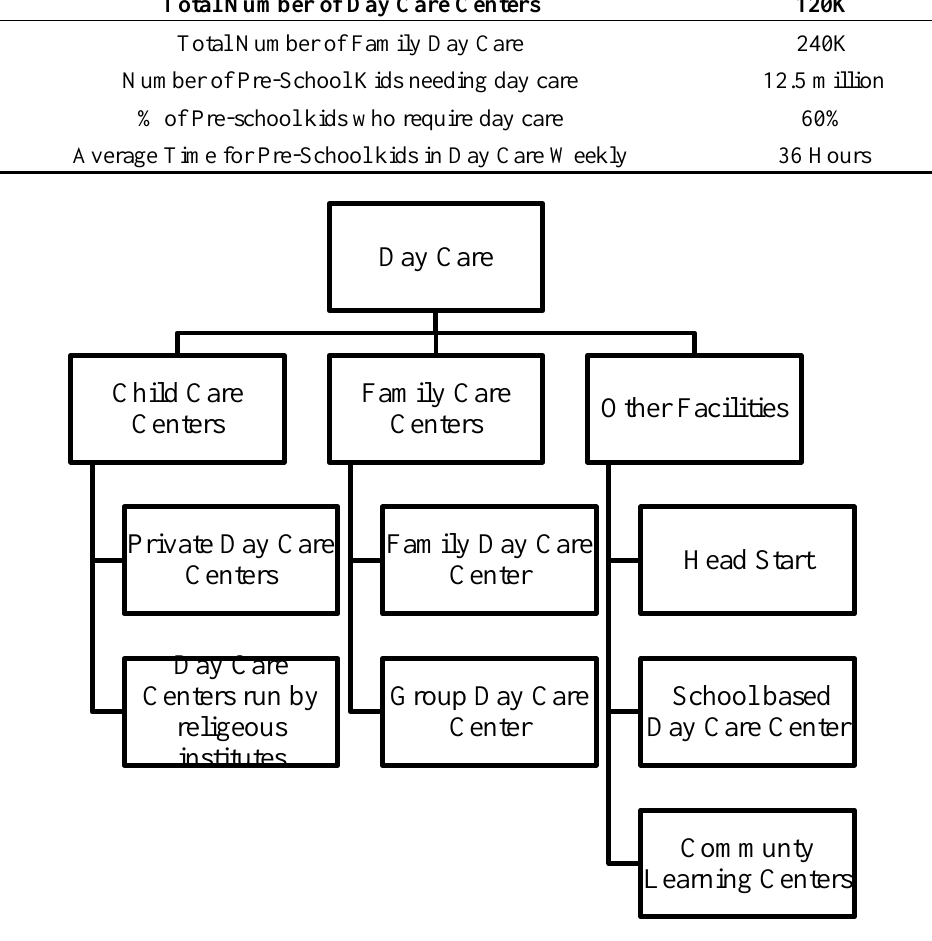
Figure 1. Schematic classification of day care